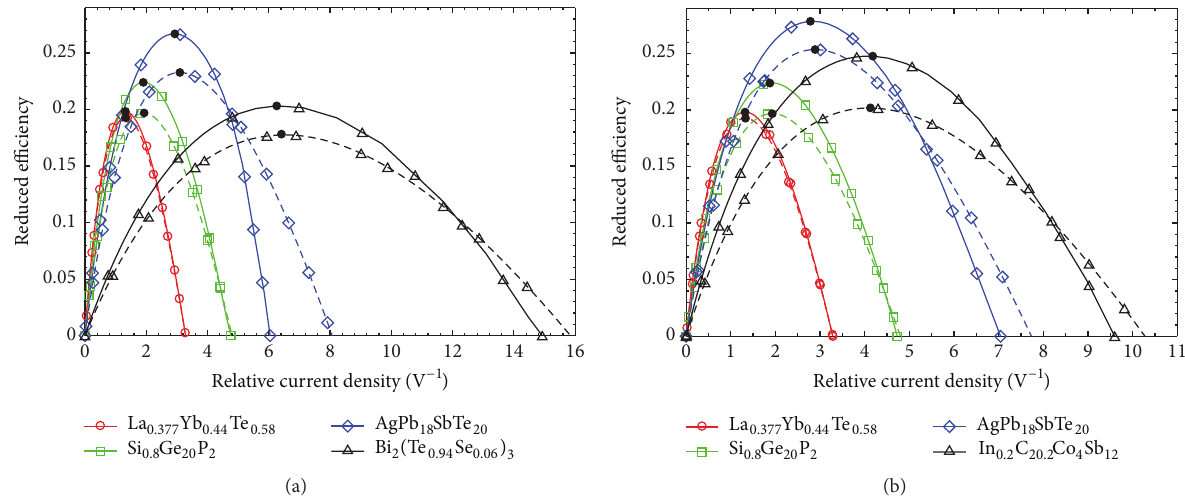
) (relative current density at 𝑇 ) for the materials used in (a) 𝑛 1-leg and (b) 𝑛 2-leg. The av av